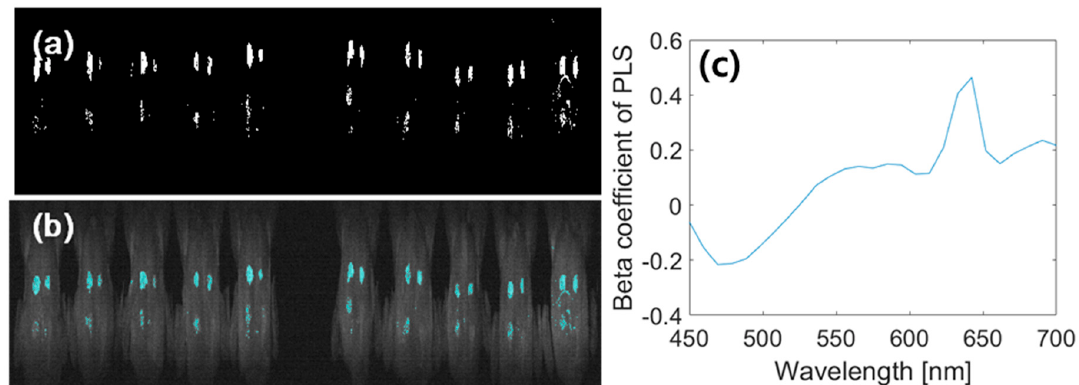
Figure 8. The resultant binary image of partial least square discriminant analysis (PLS-DA) to the multispectral images ( a ) and its projection to the sample image with a pseudo color ( b ). Beta coefficient of PLS-DA of 2 nd latent variable ( c ).